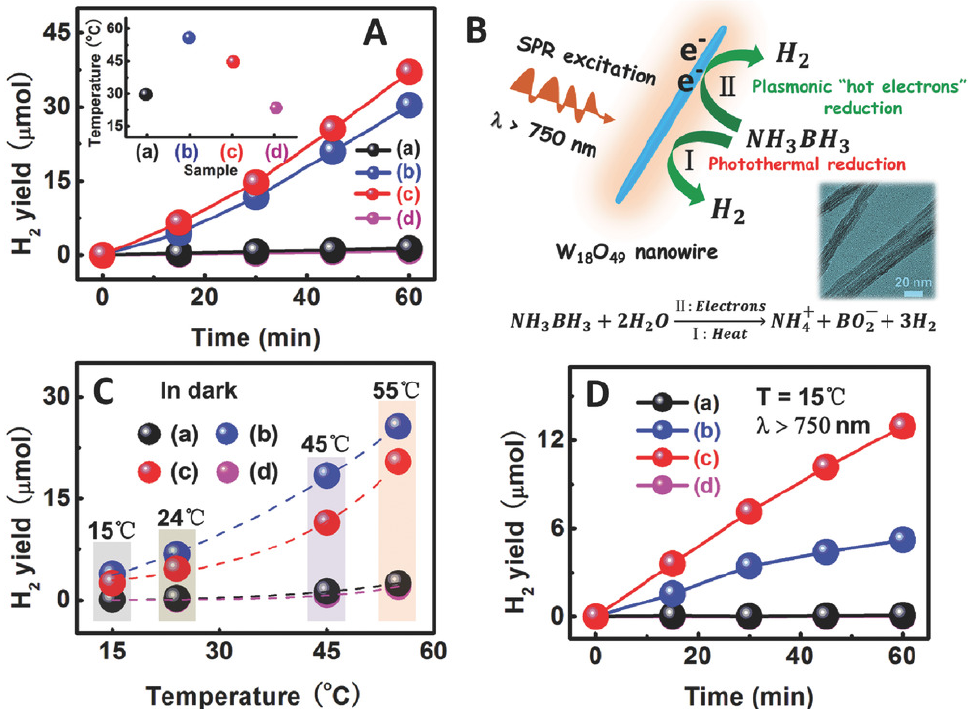
Figure 7. ( A ) Time-dependent H 2 generation from NH 3 BH 3 aqueous solution over different samples upon IR- light irradiation (λ > 750 nm) (the inset shows the corresponding catalytic reaction temperatures); ( B ) schematic of the catalytic mechanism for H 2 generation from NH 3 BH 3 molecules over the plasmonic W 18 O 49 NWs (the inset shows a TEM image of the W 18 O 49 NWs); ( C ) catalytic H 2 generation from NH 3 BH 3 aqueous solution at different temperatures for 1 h over different samples without light irradiation; ( D ) time-dependent H 2 generation from NH 3 BH 3 aqueous solution at 15 °C over different samples upon IR-light irradiation: (a) TiO 2 NFs; (b) W 18 O 49 NWs; (c) W 18 O 49 /TiO 2 branched heterostructure; (d) without a catalyst. Reprinted with permission from [102]: Zhang, Z. et al.